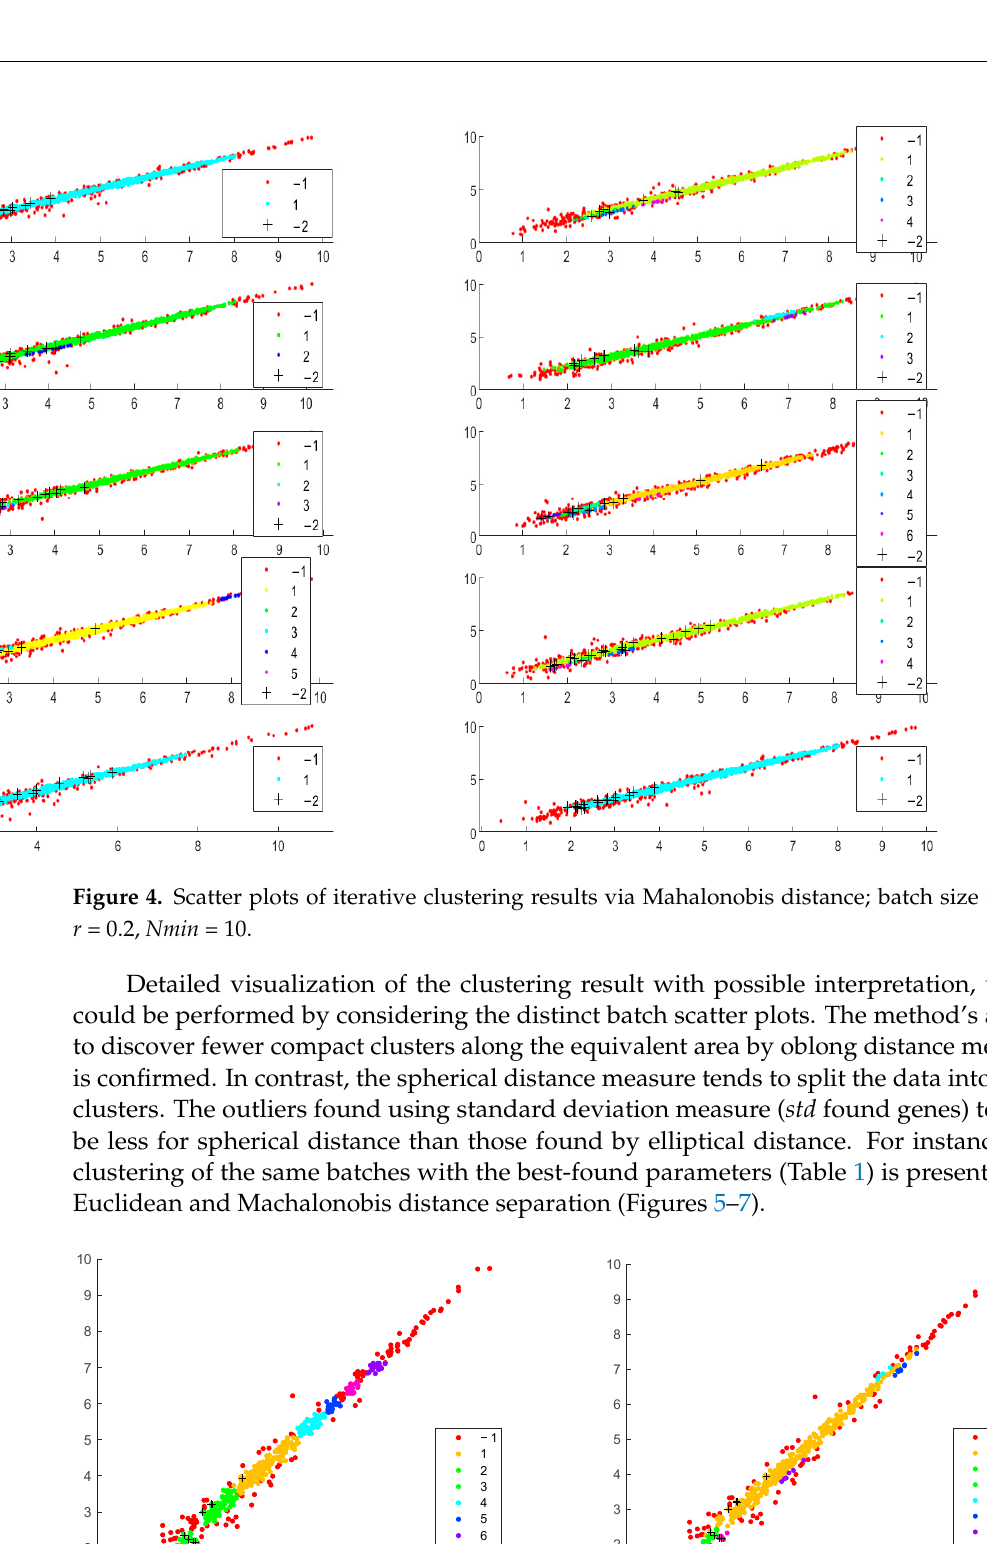
( b ) Figure 6. Clustering of the 8th batch, the batch of 511 genes; Tstd = 0.3. ( a ) Euclidean distance, 15 std genes. ( b ) Mahalonobis, 0.2, 5, 17 std genes. ( a ) ( b ) Figure 7. Clustering of the 9th batch, the batch of 1022; Tstd = 0.3. ( a ) Euclidean distance, 62 std genes. ( b ) Mahalonobis distance, 63 std genes.